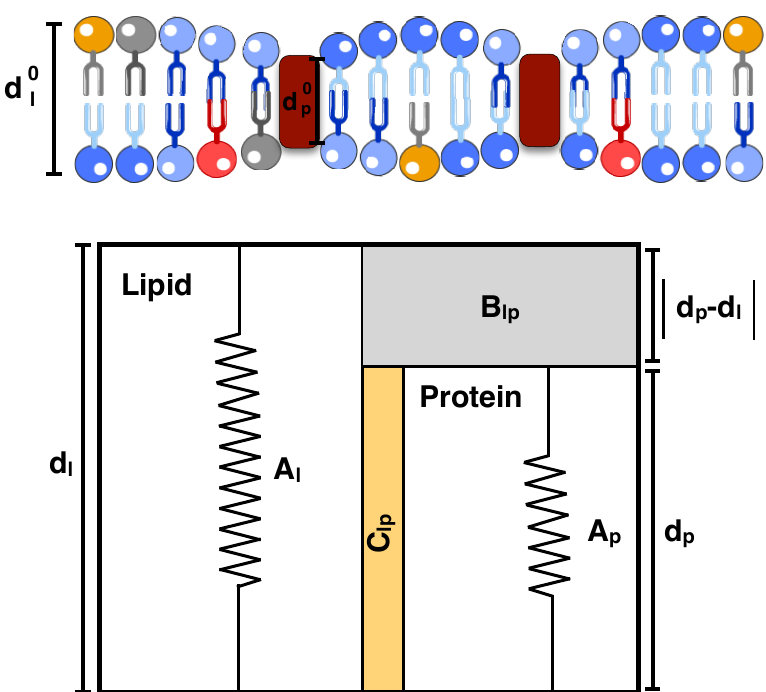
Figure 4. Mattress model representation of the hydrophobic mismatch phenomena [208]. Both protein and lipid bilayer are modeled as one-dimensional springs with constants A p and A l , respectively. d 0 and d 0 p are the initial lengths, and d l and d p are the final lengths of the lipid bilayer and the protein after deformation, respectively. The gray area corresponds to the hydrophilic region with the strength of B lp , and the yellow region indicates the adhesive region with adhesive interactions strength of C lp